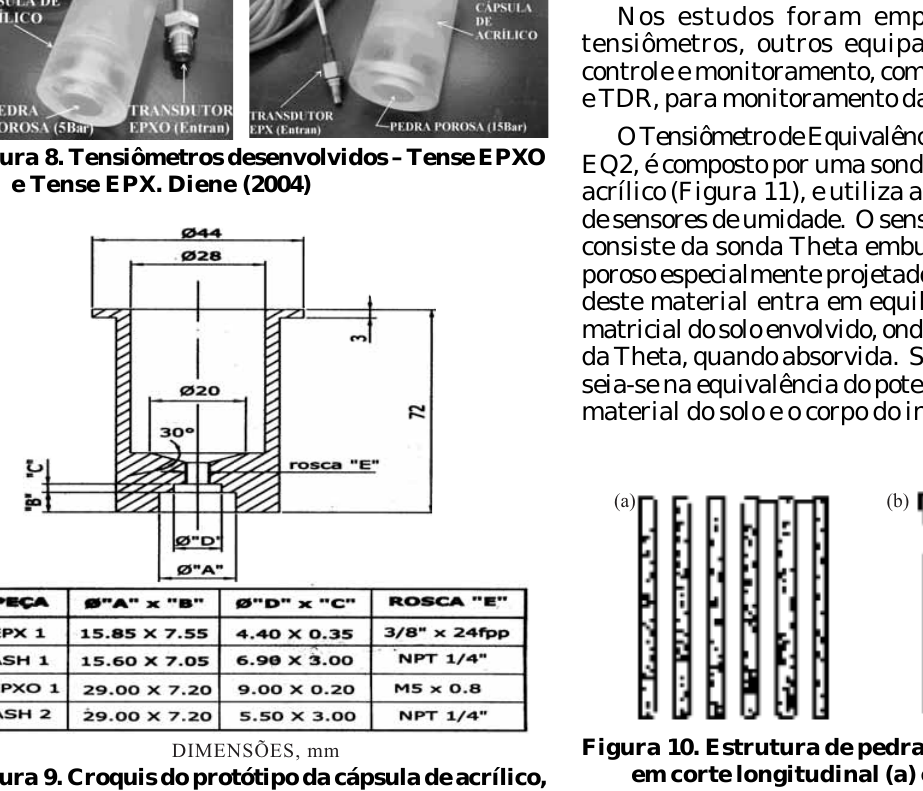
Figura 9. Croquis do protótipo da cápsula de acrílico, com suas diferentes dimensões. Diene (2004)